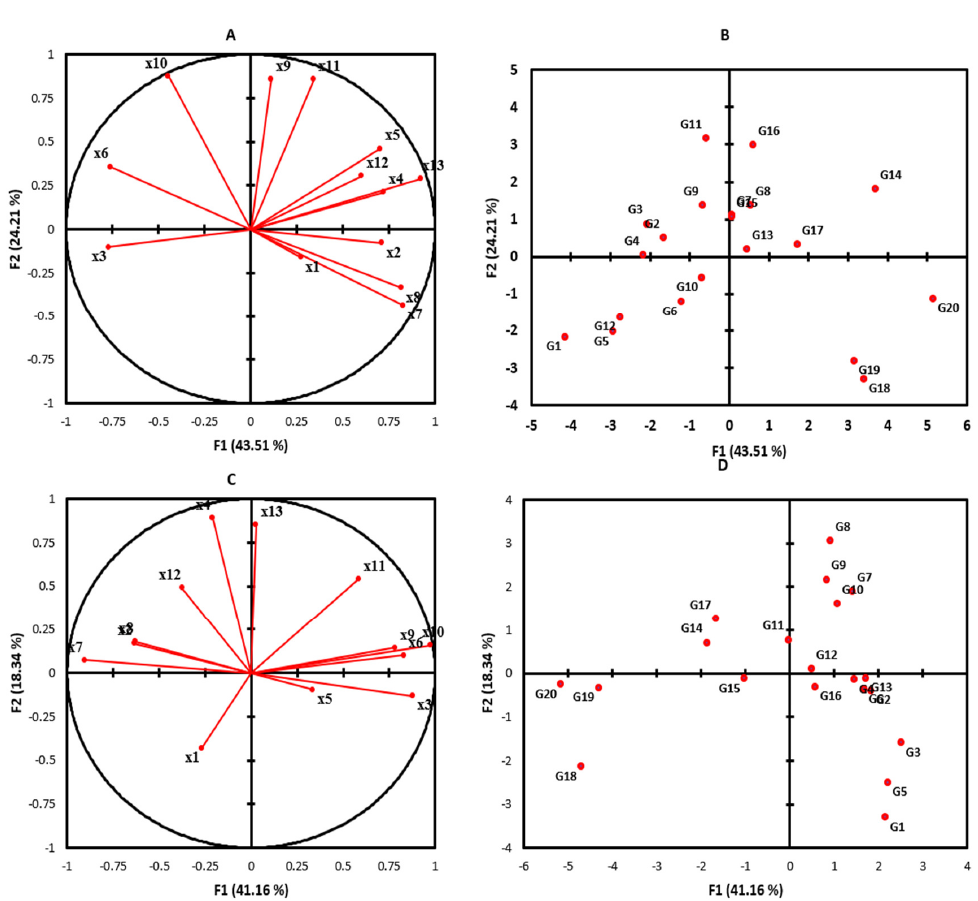
Figure 2. Biplot of the first and second components at different crop year related to different wheat genotypes [A and B (first year), C and D (second